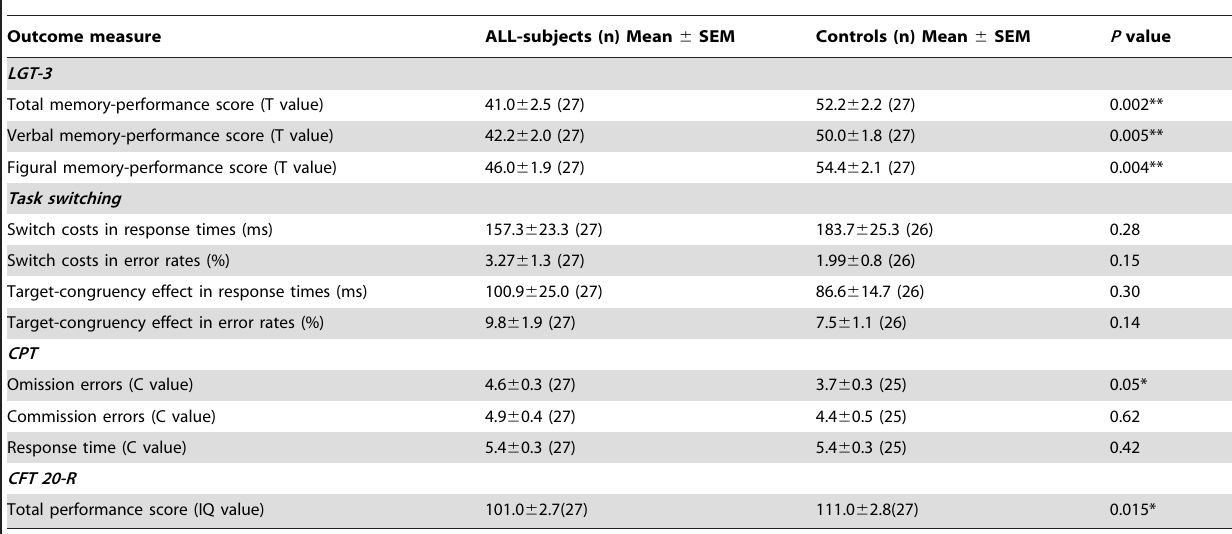
Table 6. Results of neuropsychological